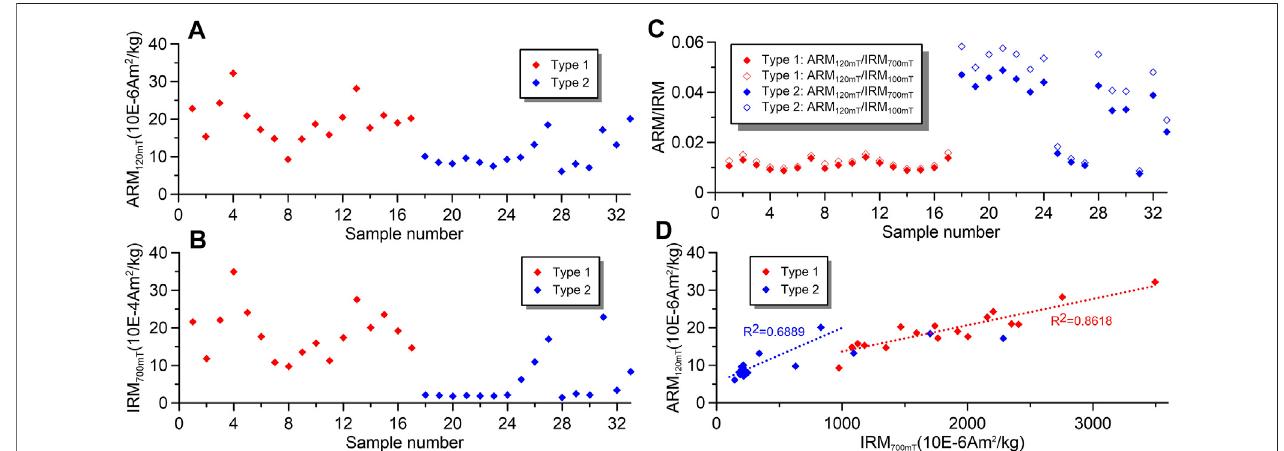
FIGURE 6 | (A, B) ARM and IRM acquired at 150 mT in a 40 μ T DC bias fi eld and 700 mT respectively. (C) ARM versus IRM at sample level. (D) ARM versus IRM diagram con fi rming the uniformity in magnetic grain size for Types 1 and 2. The coef fi cient of determination of the least-square fi tting is indicated for each data group.